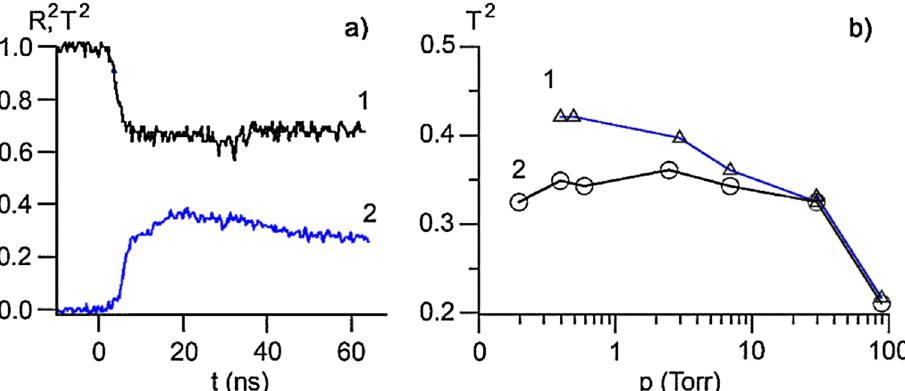
FIG. 5. (Color) (a) Characteristic oscillograms of the reflected and transmitted signals (1 and 2, respectively) for the plasma switch with active and passive sections; (b) dependence of the switch transmission coefficient on the pressure of the gas in the tubes: 1—with one gas-discharge tube, 2—with two gas-discharge